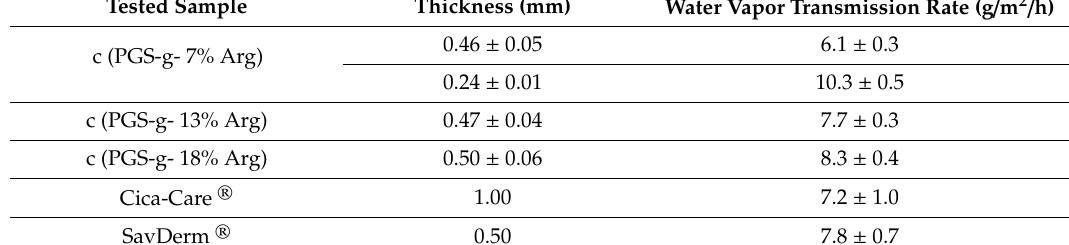
Table 3. Comparison of the water vapor transmission rates (WVTRs) of c(PGS-g-Arg) with commercial products by vial method ( n = 3).